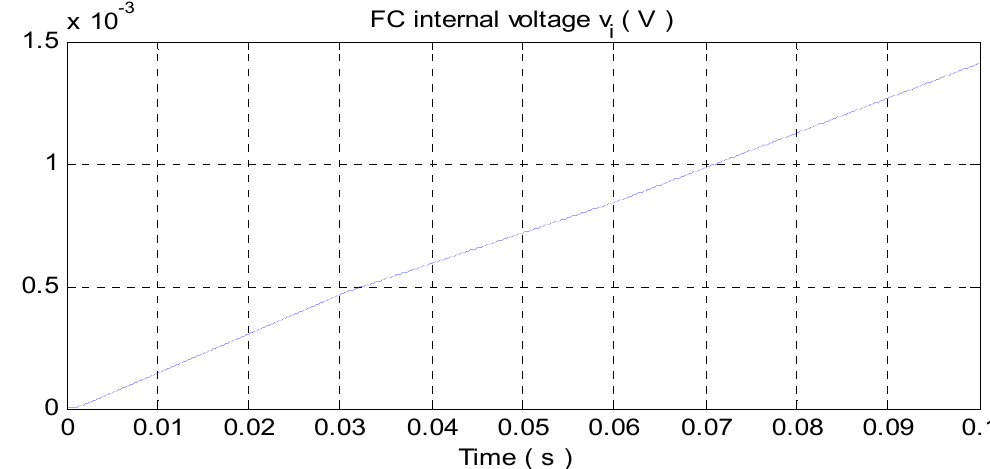
Figure 13. Error e 2 between the capacitor voltage v c and its desired value x 2 d .